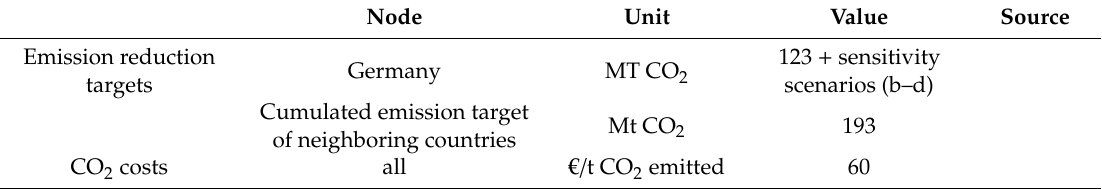
Table A5. Emission targets for Germany and its neighboring countries as well as CO 2 costs.